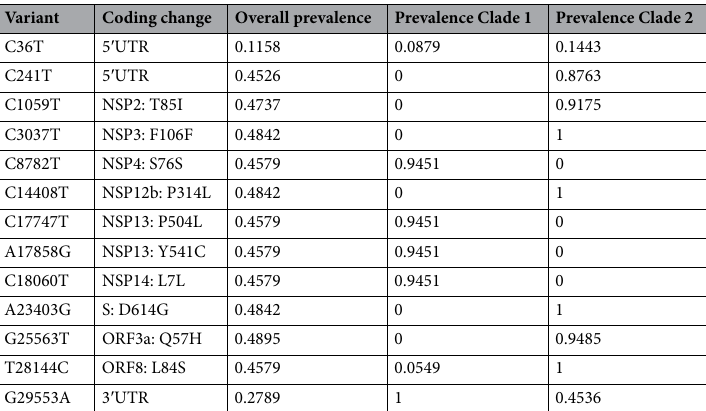
Table 3. Distribution of sequence variants occurring more frequently than 5% in the study